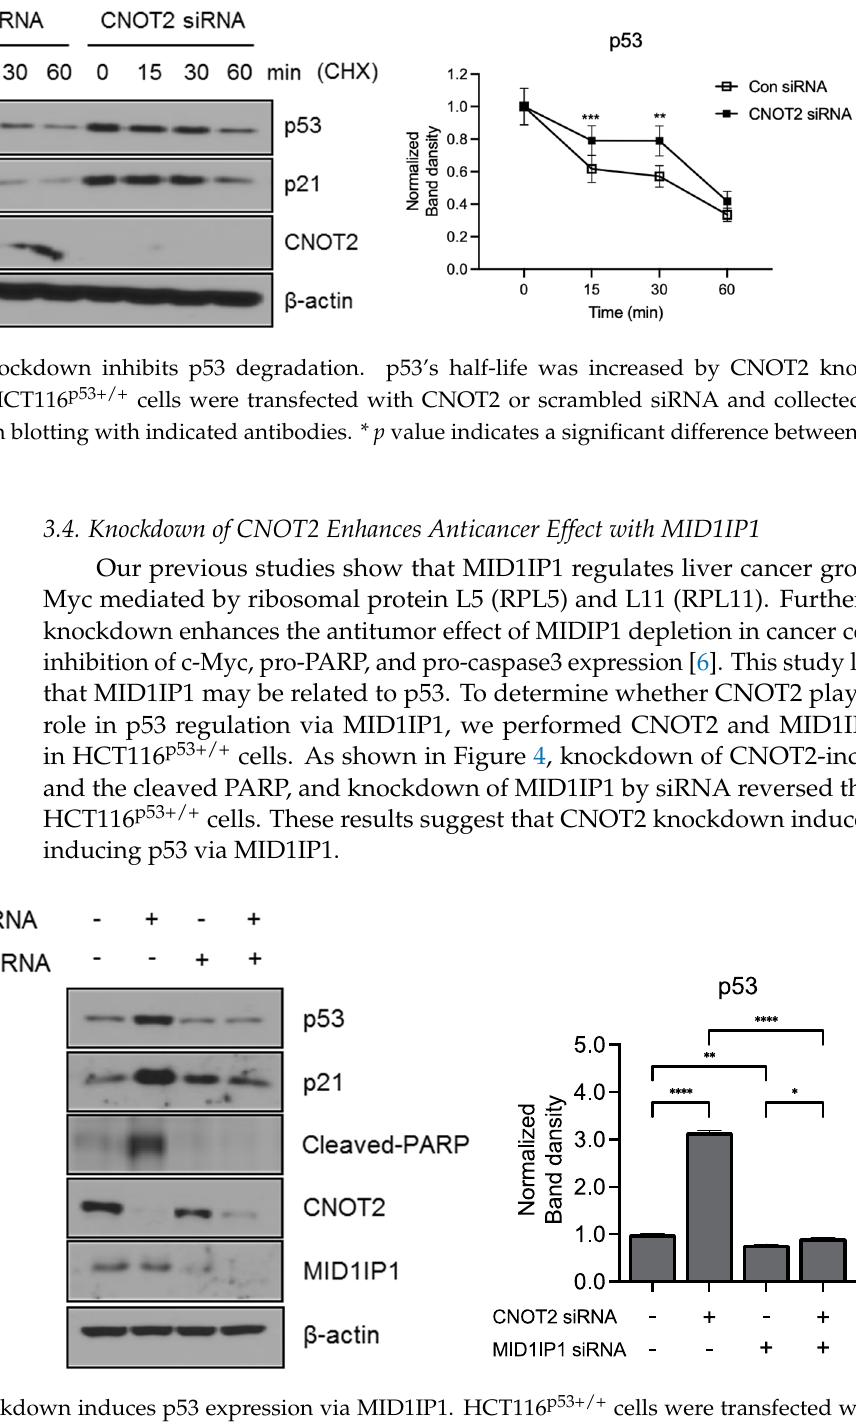
Figure 4. CNOT2 knockdown induces p53 expression via MID1IP1. HCT116 p53+/+ cells were transfected with CNOT2 siRNA with or without MID1IP1 siRNA, and harvested for Western blotting with the indicated antibodies. * p value * p < 0.05, ** p < 0.01, **** p < 0.001.